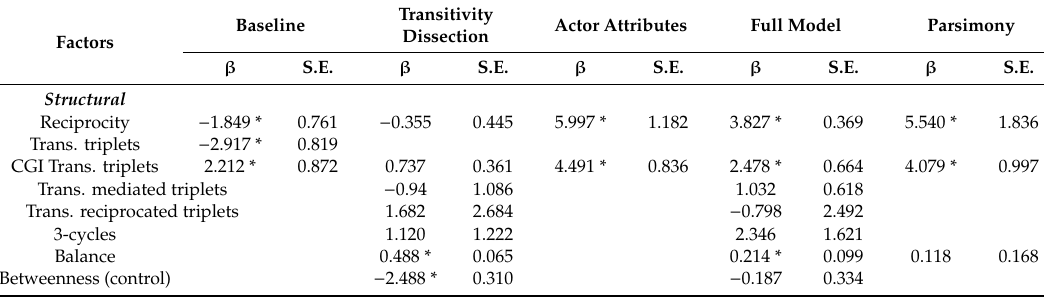
Table 4. SAOM Investigation of Structural Complexity (* p <